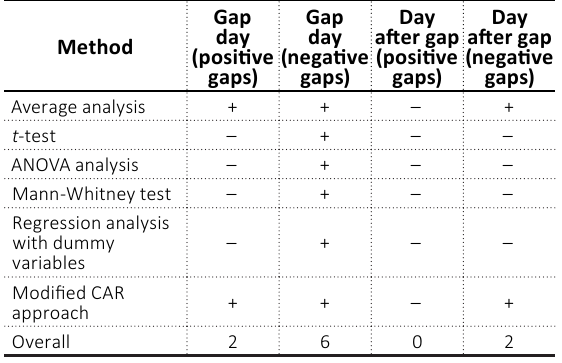
Table 4. Overall results for the Ukrainian stock